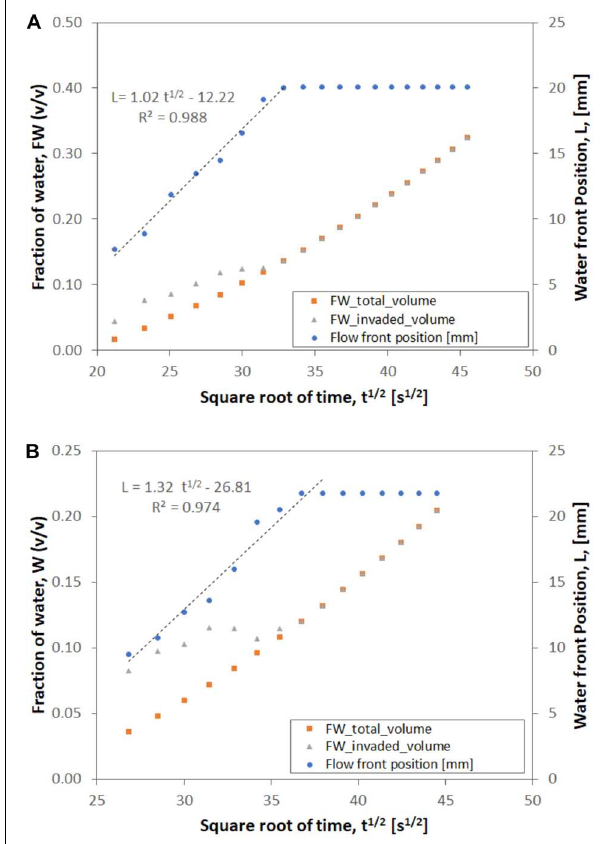
FIGURE 6 | Water absorption in function of time described by the axial waterfront position, the fraction of water invading the whole sample and the fraction of water only in the invaded rock volume: (A) Favignana grainstone and (B) Orfento